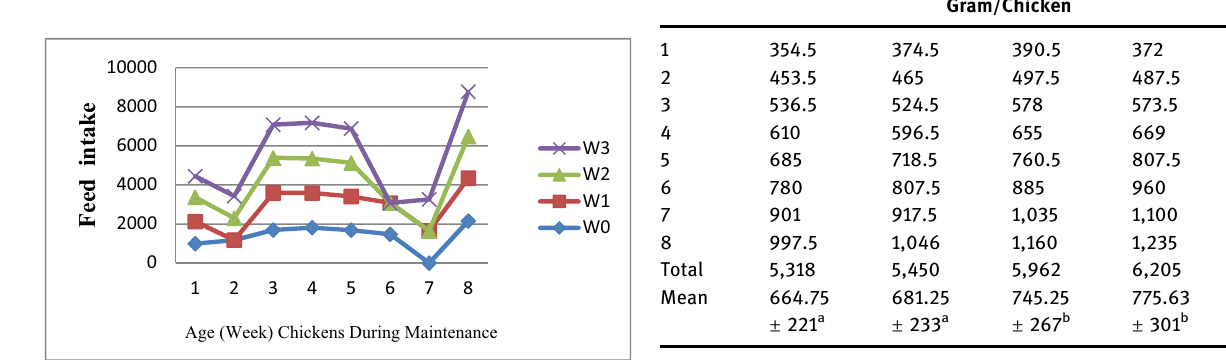
Figure 2: Feed intake of chickens during 8 weeks of research.